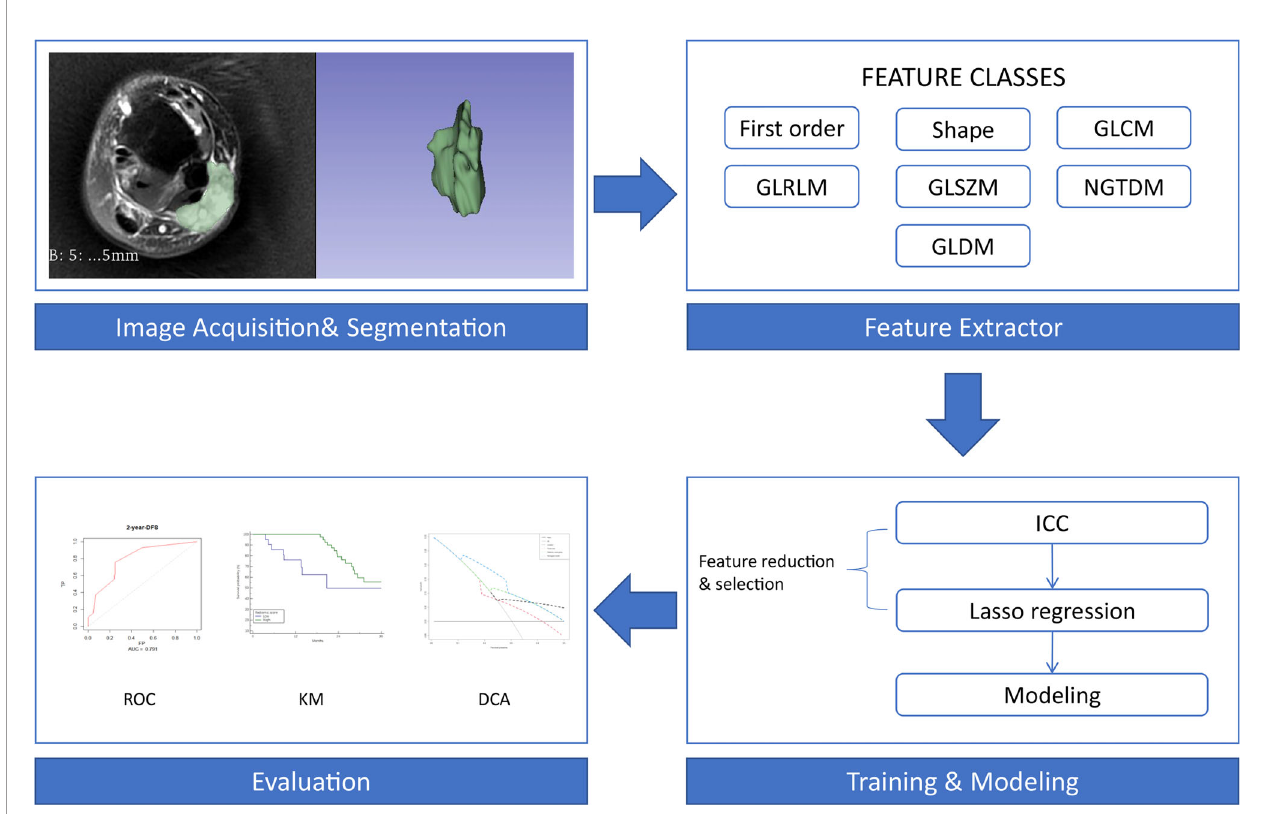
FIGURE 1 | Work fl ow of the radiomics analysis. First-order, fi rst-order statistics; Shape, shape-based (3D) features and shape-based (2D) features; GLCM, grey-level cooccurrence matrix; GLRLM, grey-level run length matrix; GLSZM, grey-level size zone matrix; NGTDM, neighbouring grey tone difference matrix; GLDM, grey-level dependence matrix; ICC, intraclass correlation coef fi cient; ROC, receiver operating characteristic curve; KM, Kaplan-Meier survival curve; DCA, decision curve